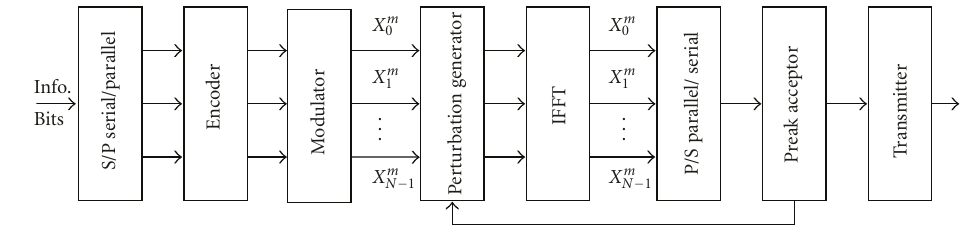
Figure 1: OFDM system with frequency-domain perturbation.